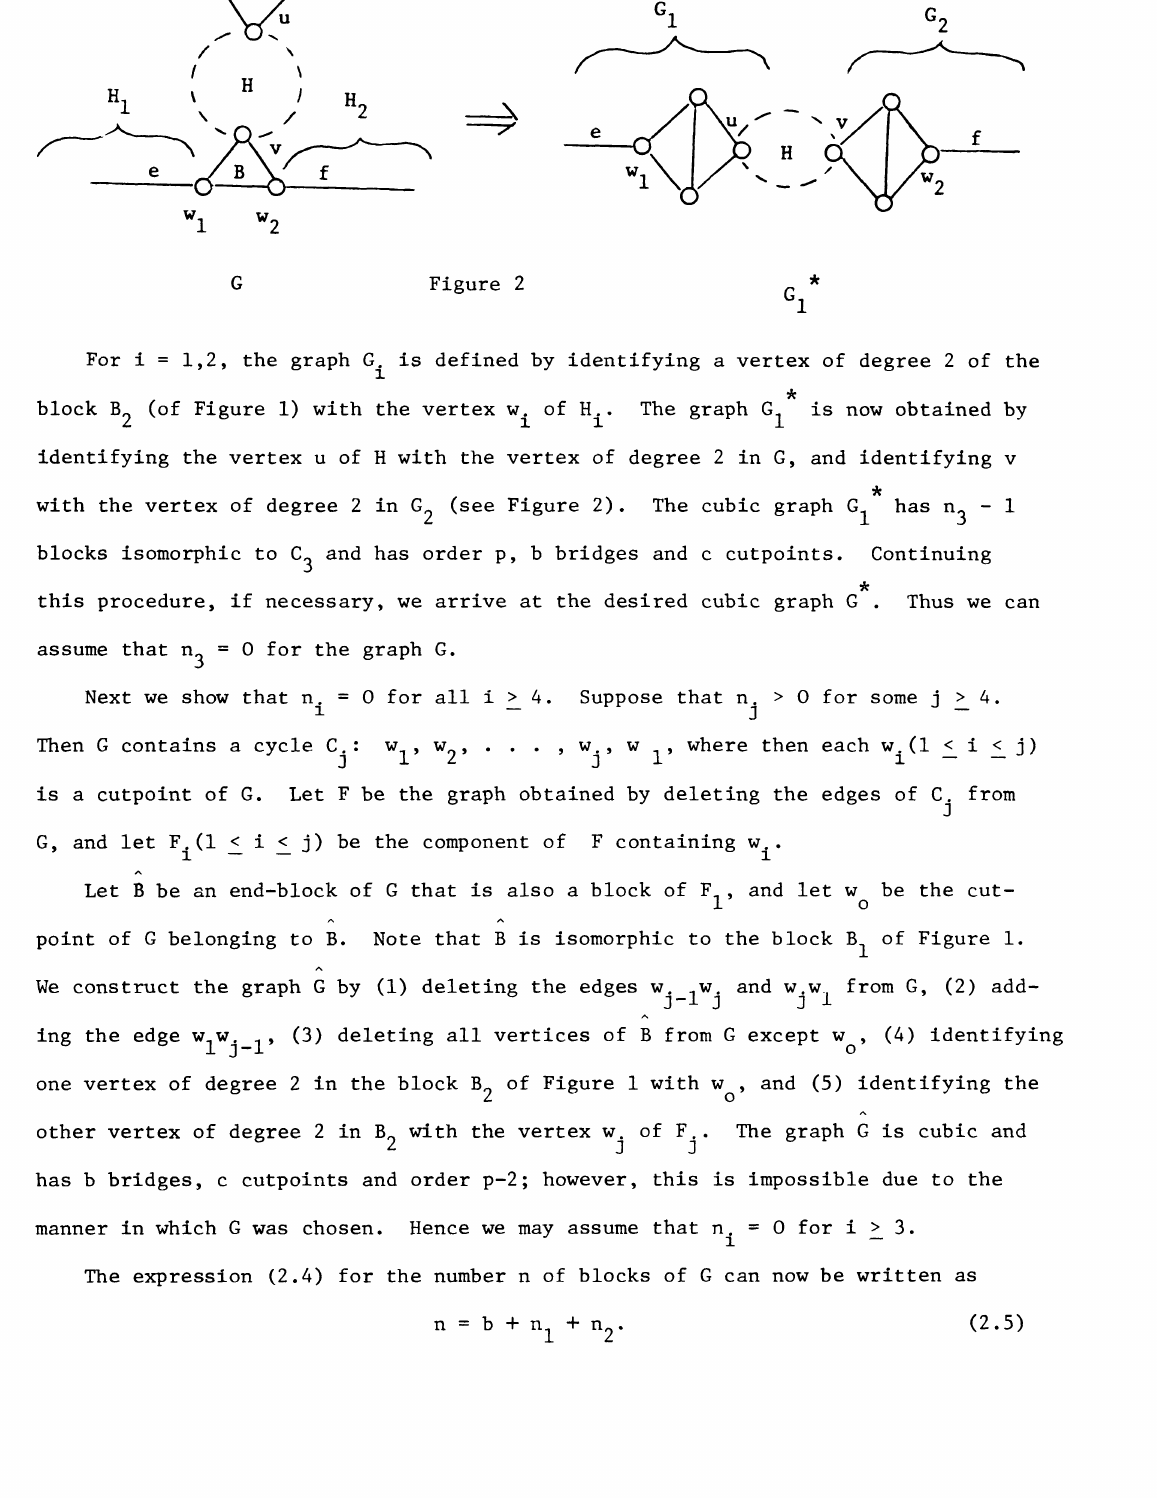
For i 1,2, the graph G. is defined by identifying a vertex of degree 2 of the (of Figure 1) with the vertex w.1 of H..1 The graph G block B 2